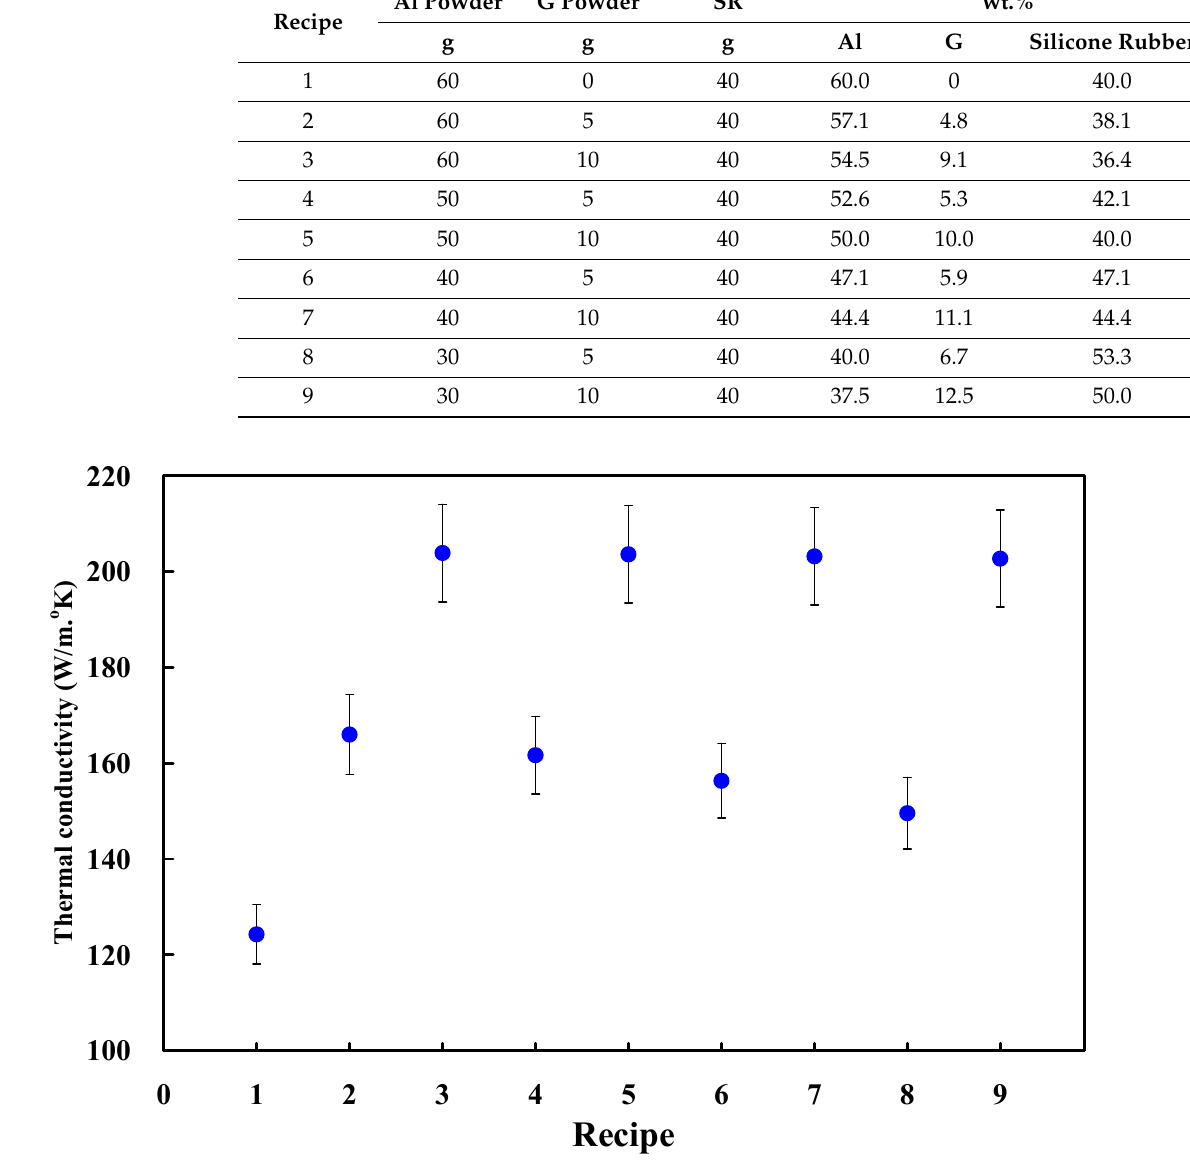
Figure 5. Recipe as a function of thermal conductivity.